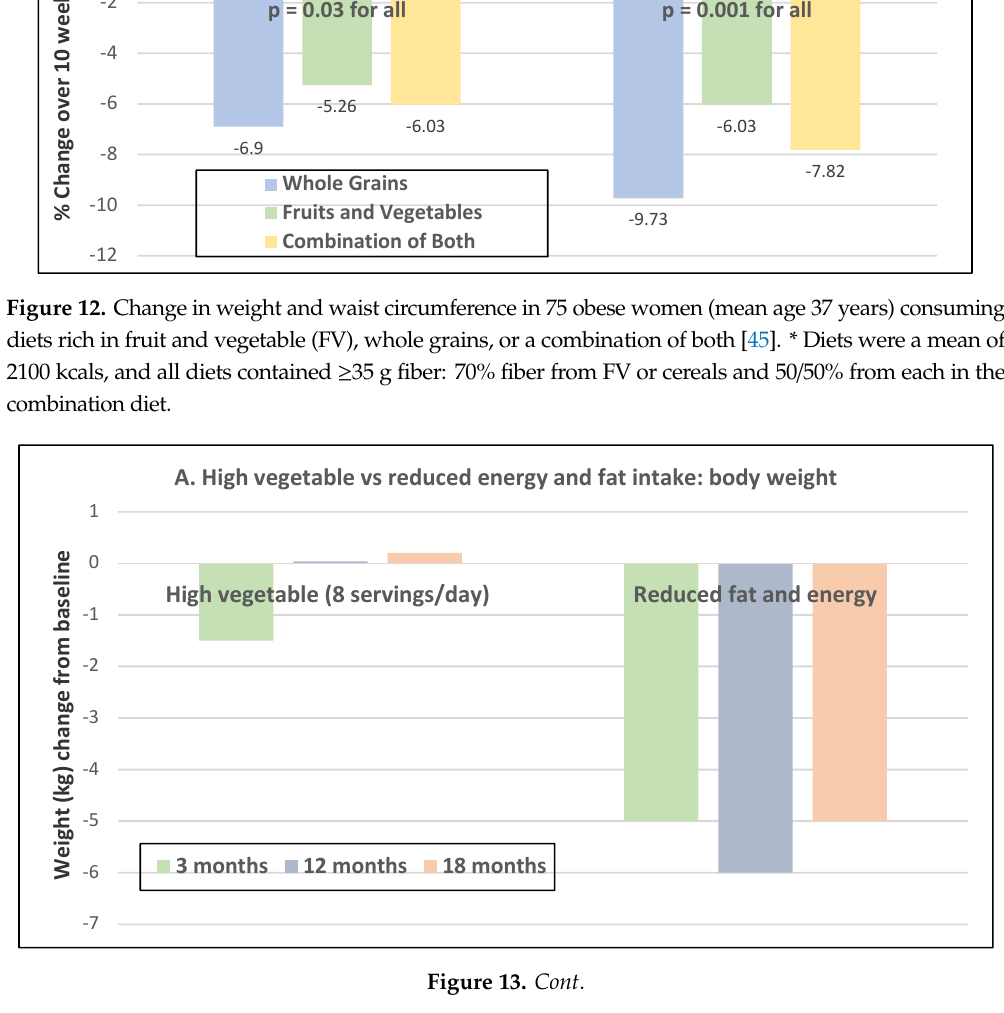
supervision, significantly reduced weight and WC after ten weeks (Figure 12) [45].